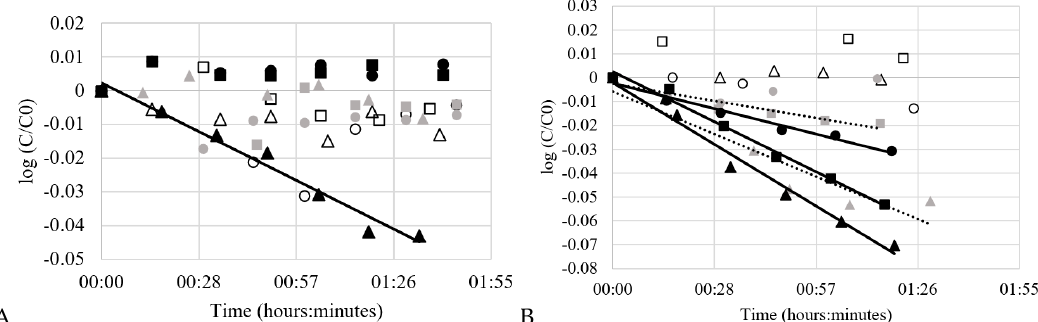
Figure 3. Thermal degradation kinetics of quercetin in: ( A ) CO 2 -expanded ethanol and ( B ) CO 2 - expanded ethyl lactate. For 308 K: ∆ 10% mol CO 2 , □ 30% mol CO 2 , and ○ 50% mol CO 2 . For 323 K: ▲ 10% mol CO 2 , ■ 30% mol CO 2 and ● 50% mol CO 2 . For 343 K: ▲ 10% mol CO 2 , ■ 30% mol CO 2 , and ● 50% mol CO 2 . Mean values, n = 3.